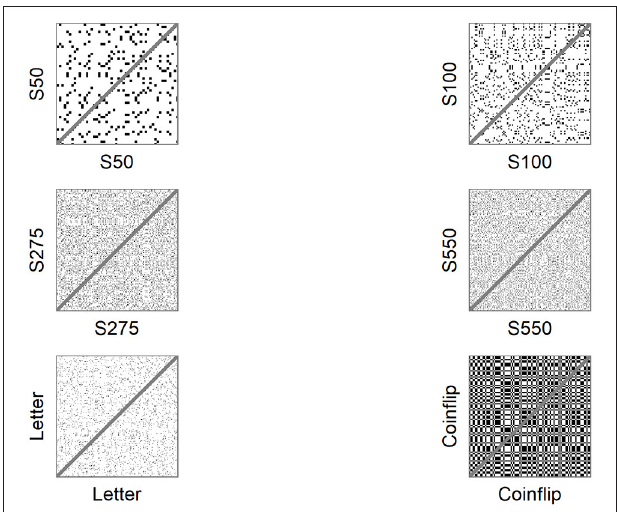
FIGURE 1 | Auto-recurrence plots of sample